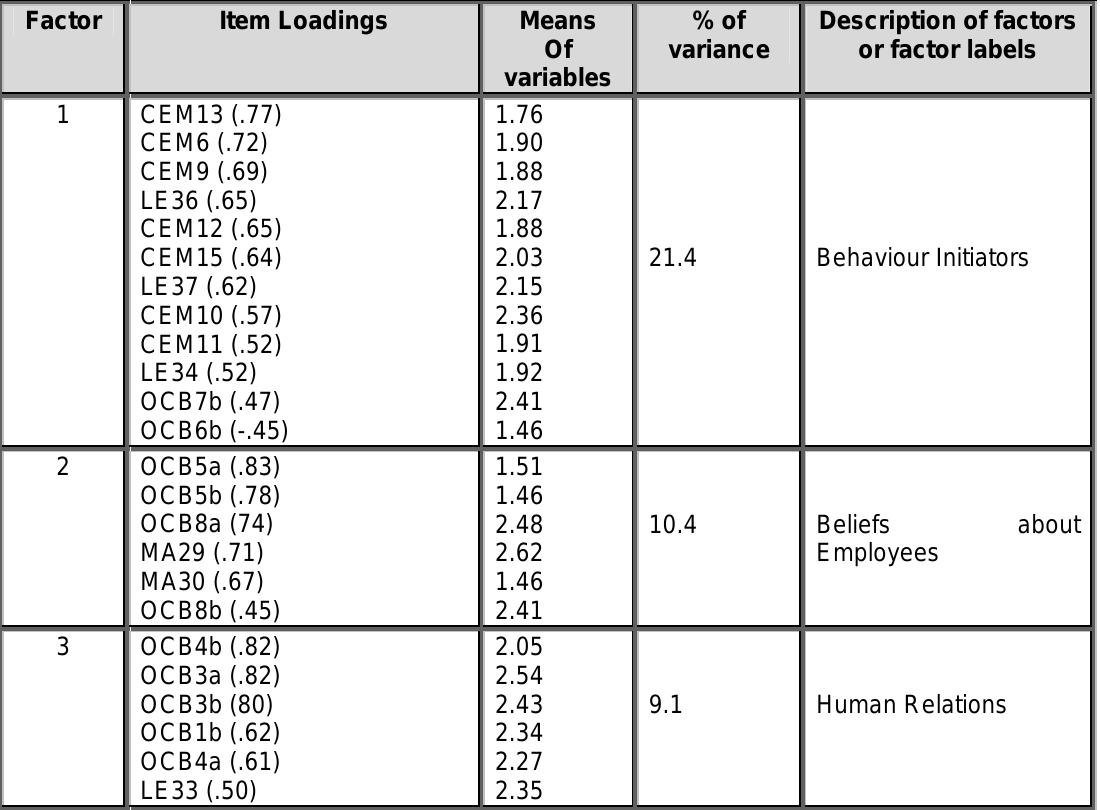
Table 4: Factor structure of employee motivation in Ghana